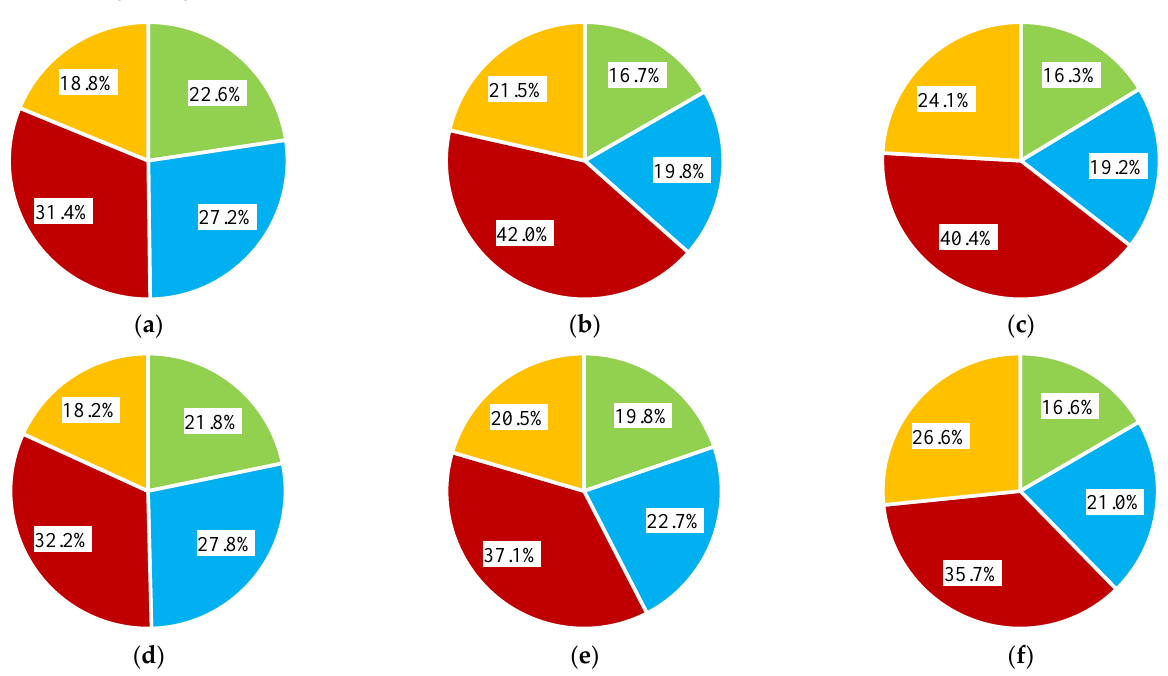
Figure 9. Seismic loss compositions of buildings of different structural types. ( a ) SLE before retrofitting; ( b ) DBE before retrofitting; ( c ) MCE before retrofitting; ( d ) SLE after retrofitting; ( e ) DBE after retrofitting; ( f ) MCE after retrofitting.